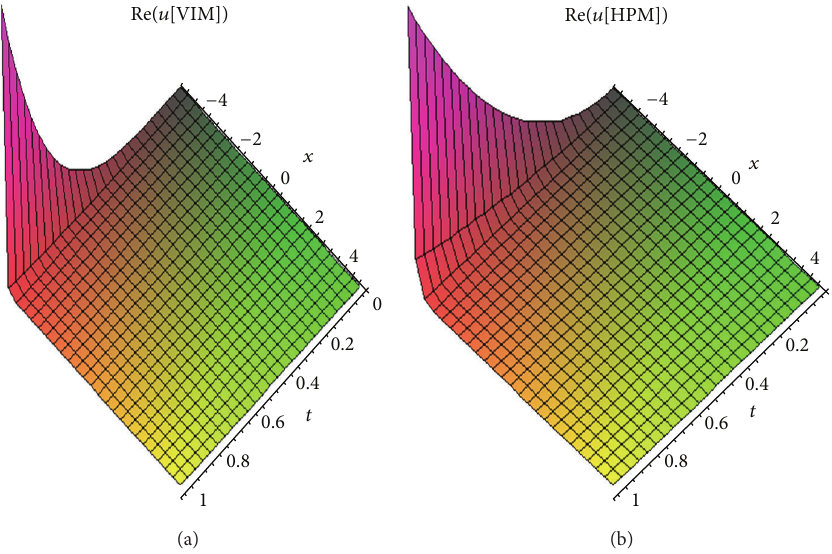
Figure 4: The real part of the approximate solution obtained by the variational itearation method (38) shown in (a) in comparison with that of the approximate solutions obtained by homotopy perturbation method (32) shown in (b) when 𝛼 = 0.99 , 𝛽 = 0.99 , −5 < 𝑥 < 5 , and 0 < 𝑡 < 1 .